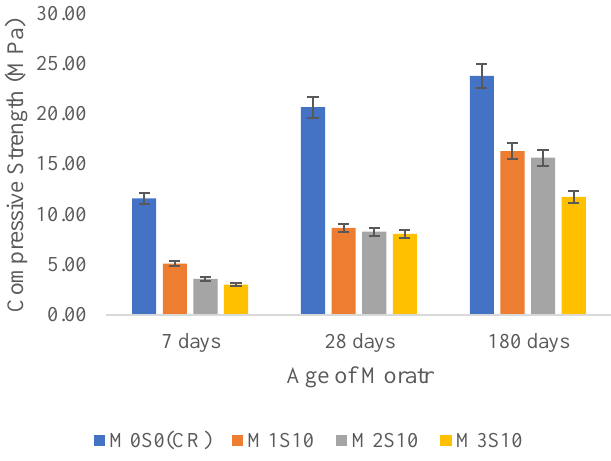
Figure 11. Effects of SDPMF content and 10% SF on mortars’ compressive strengths.